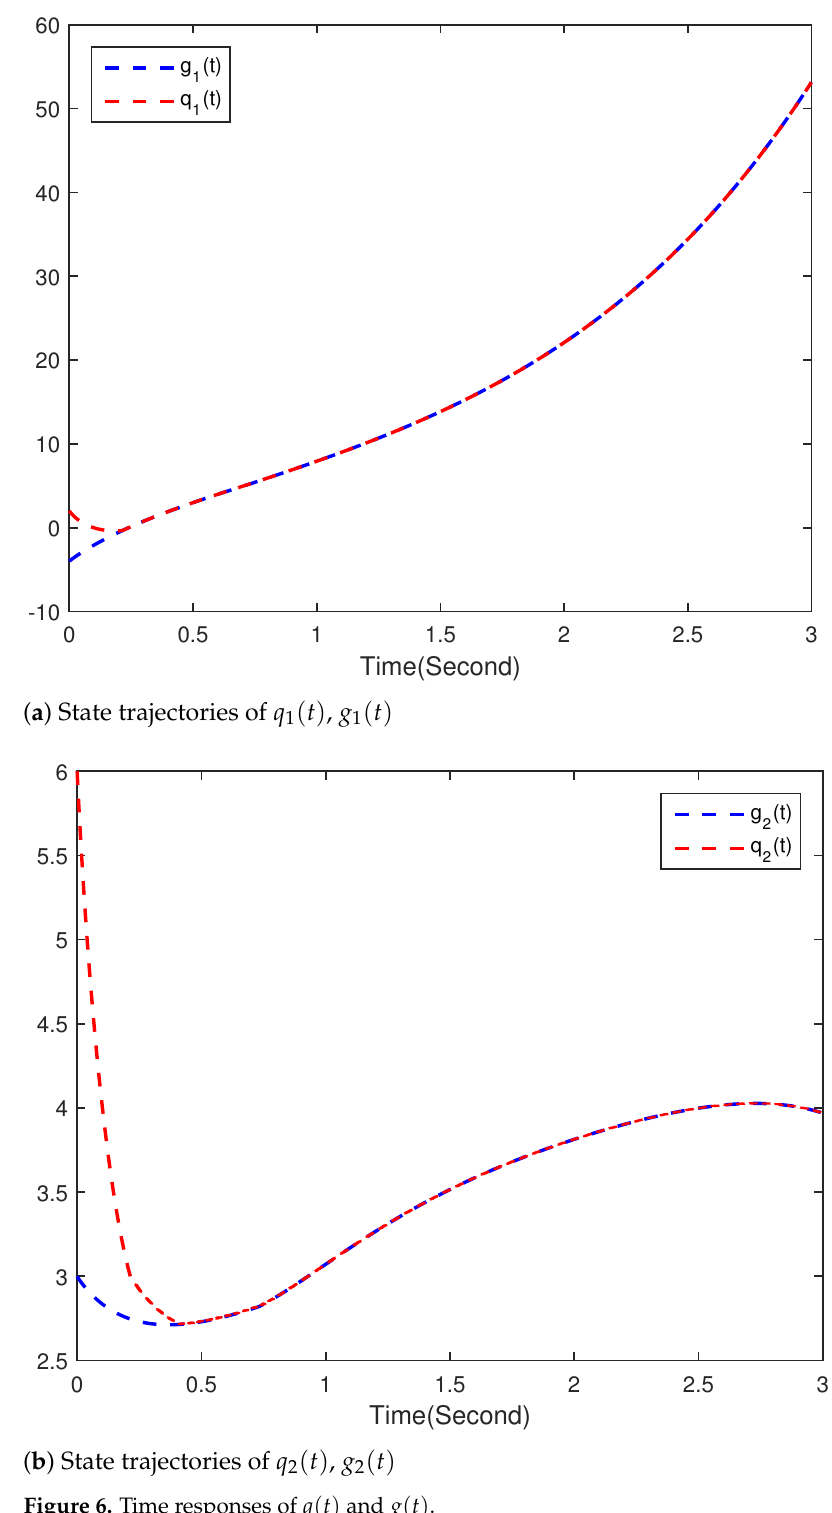
Figure 6. Time responses of q ( t ) and g ( t )